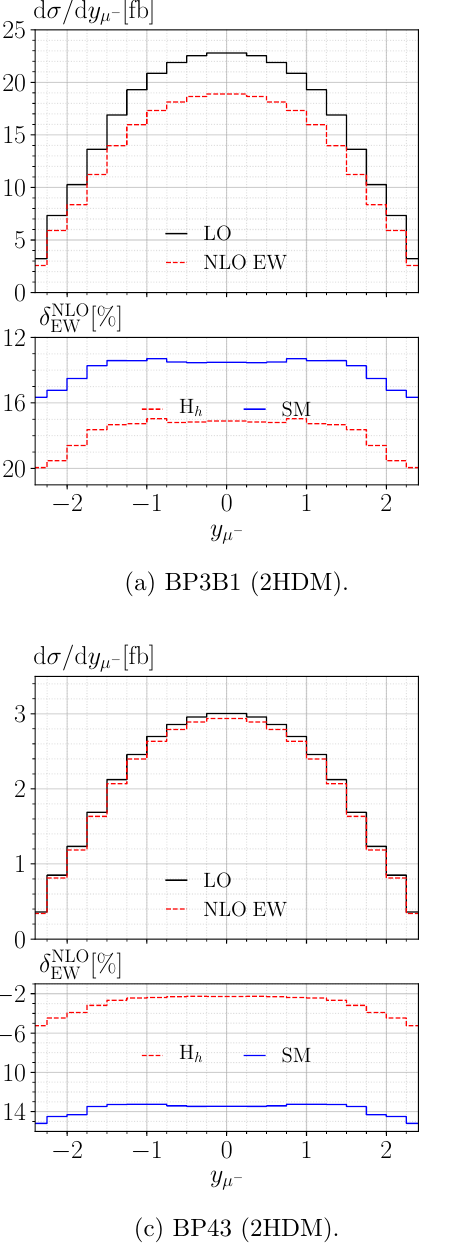
for heavy Higgs production in Higgs (cid:22) (cid:0)